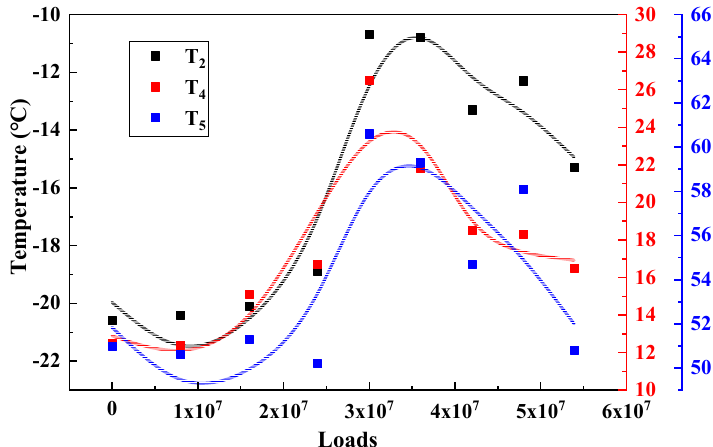
Figure 9. Characteristic temperature variation of STR1/3.